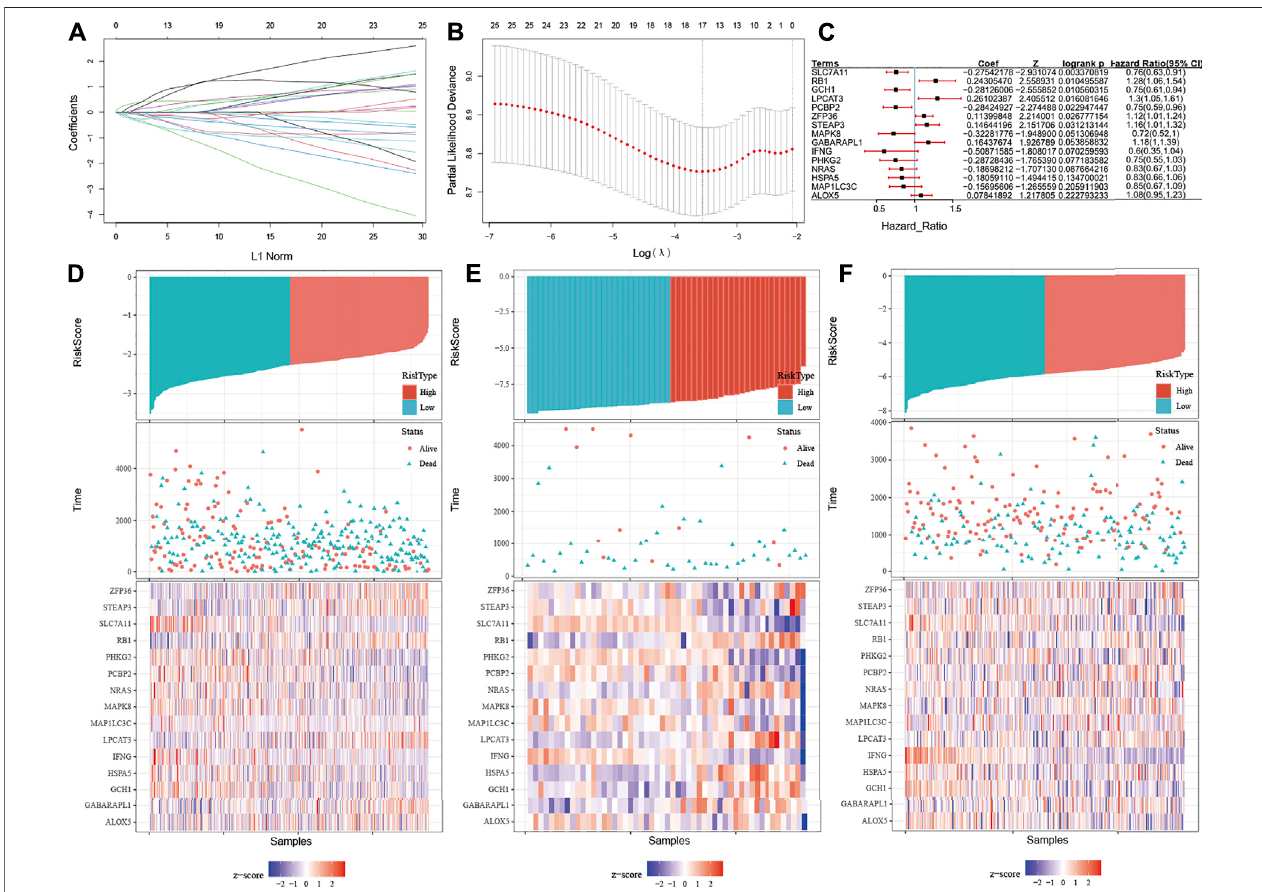
FIGURE 6 | Construction of the E-FRG model by integrating ESTIMATE and FRGs. (A) LASSO coef fi cient pro fi les of the 23 FRGs, immune score, and stromal score. Coef fi cient pro fi le plot was produced versus the log ( λ ). (B) Tuning parameter ( λ ) selection in the LASSO-Cox regression model was performed using 10-fold cross-validation via the1 standard error for the minimum criteria. Black vertical lines were plotted at the optimal λ based on the minimum criteria and 1 standard error for the minimum criteria. (C) Forest plot showing p- values of FRGs in the model indicated by the color scale presented on the side. Horizontal bars represent 95% con fi dence intervals. (D – F) Distribution between the high E-FRG score group and low E-FRG score group in the TCGA dataset (D) , GSE18520 (E) , and GSE32062 (F) , respectively.